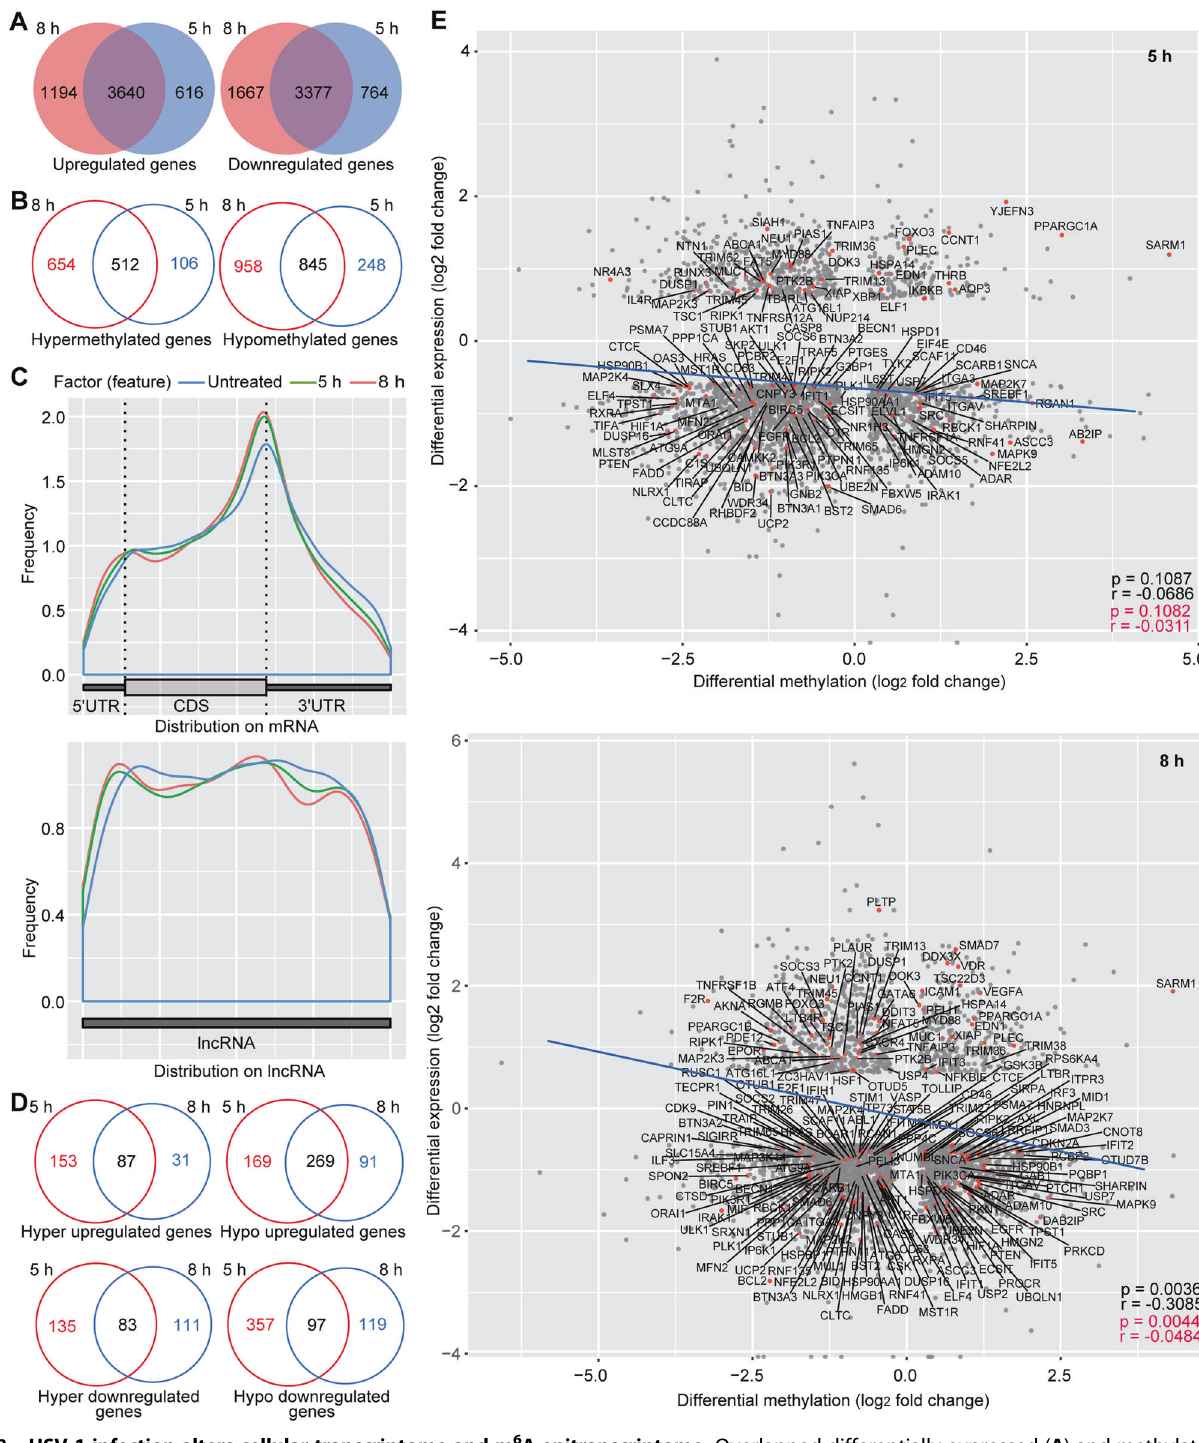
Fig. 3 HSV-1 infection alters cellular transcriptome and m 6 A epitranscriptome. Overlapped differentially expressed ( A ) and methylated ( B ) genes following HSV-1 infection for 5 and 8 h. C Overall m 6 A distribution on cellular mRNA and lncRNA at different time points following HSV- 1 infection. D Overlapped differentially expressed genes with hypermethylation and hypomethylation following HSV-1 infection for 5 and 8 h. E Correlation of mRNA expression level and m 6 A level for differentially expressed and methylated genes at 5 and 8 h HSV-1 post-infection. The regression lines are marked in “ blue ” . Innate immune related genes are marked with “ red dots ”